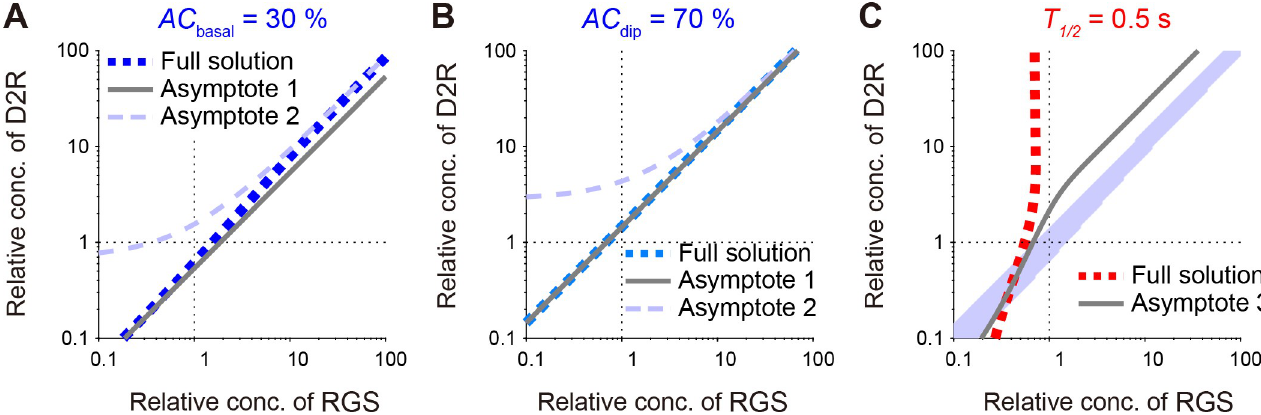
Fig 5. DA-dip detectable regions are characterized by asymptotic functions. (A, B) Analytical isolines of AC basal and AC dip ( AC basal = 30%, blue dotted line; AC dip = 70%, light-blue dotted lines) are characterized by a transition between two linear functions, Eq (14) and Eq (15) (gray and light-blue dashed lines, respectively). (C) Analytical iso- T 1/2 line ( T 1/2 = 0.5 s, red dotted line) is approximated by the function Eq (19) (gray dashed line) if it is located within AC basal < 30% and AC dip > 70% (blue shaded